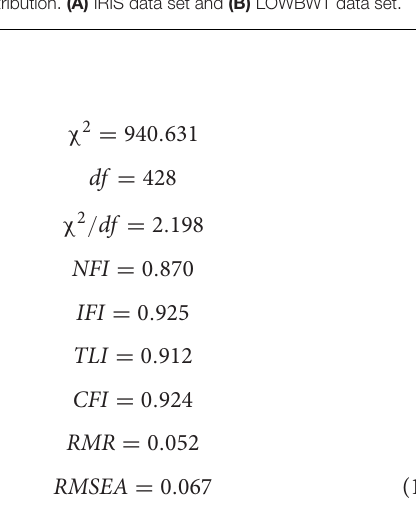
FIGURE 7 | Data distribution. (A) IRIS data set and (B) LOWBWT data